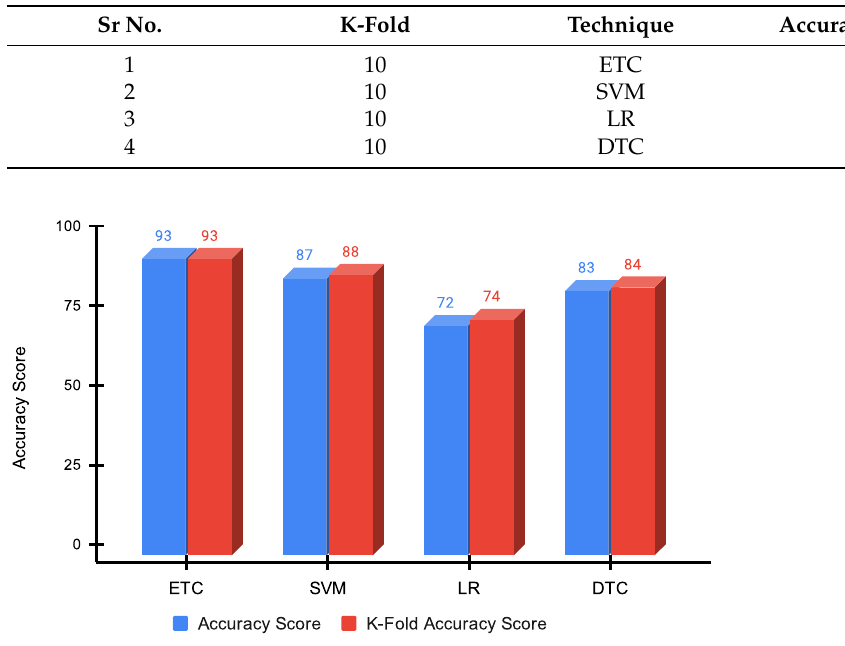
Figure 8. The comparative performance analysis of employed approaches with K-Fold validation.